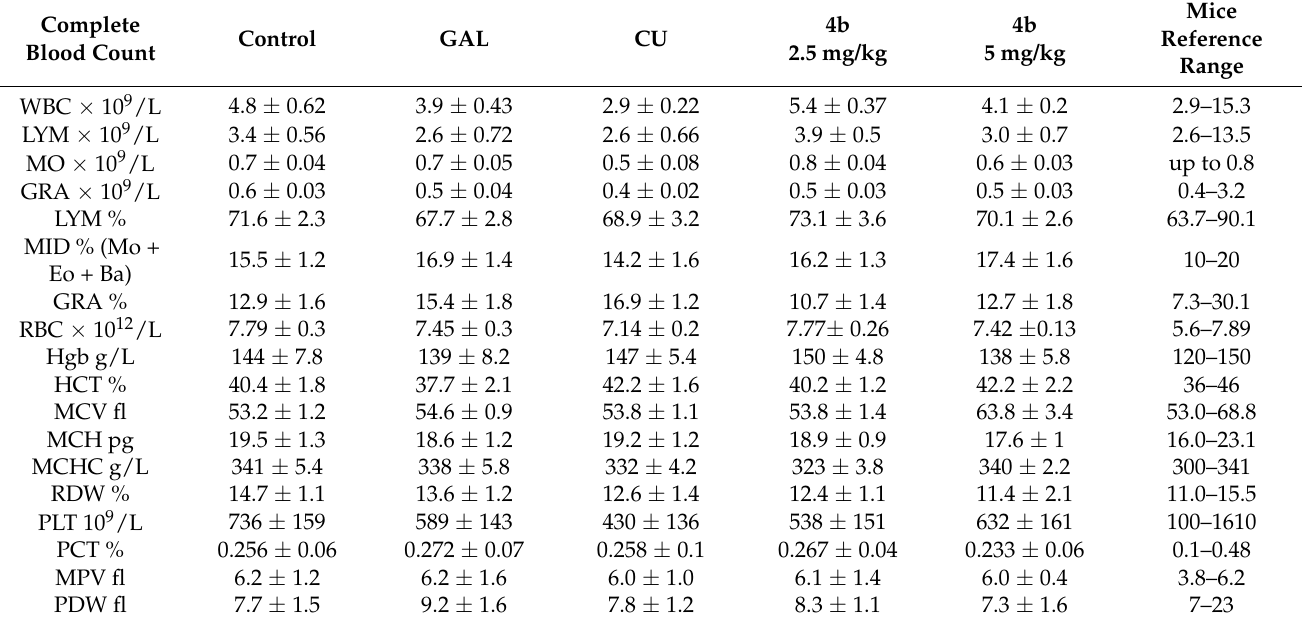
Table 1. Hematological data after 14 days of treatment by GAL, CU, and two doses of 4b or placebo. Values are means ± standard deviation ( n = 6). Mice reference ranges are given according to analyzer’s